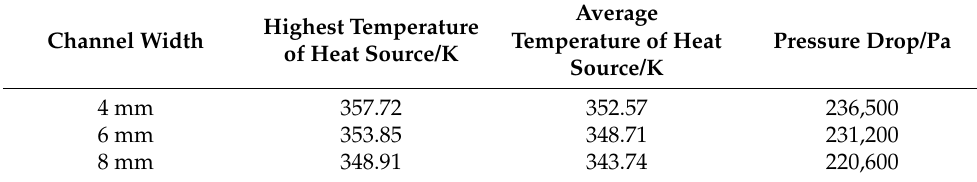
Table 4. Numerical results of different channel width.